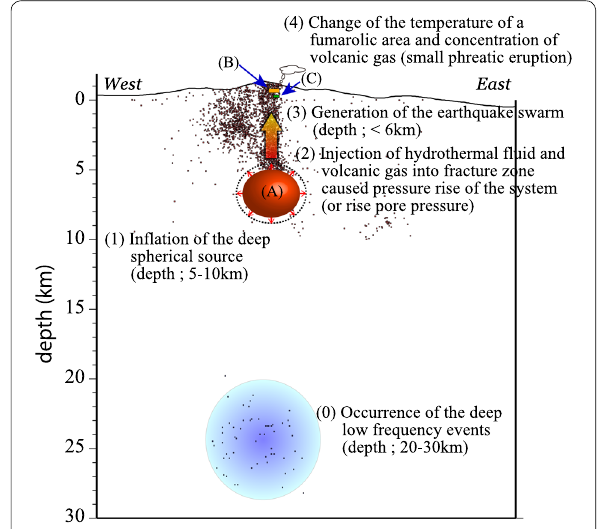
Fig. 3 Conceptual diagram of the 2015 unrest of Hakone volcano. (A), (B), and (C) are the inflation sources listed in Table 1. These sources are depicted as larger than the actual sizes for